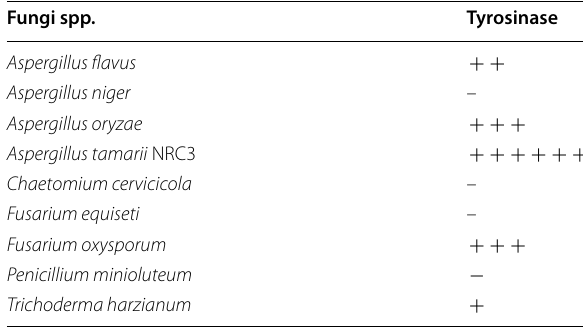
Table 1 Screening of extracellular tyrosinase production of the nine fungi species tested (qualitative